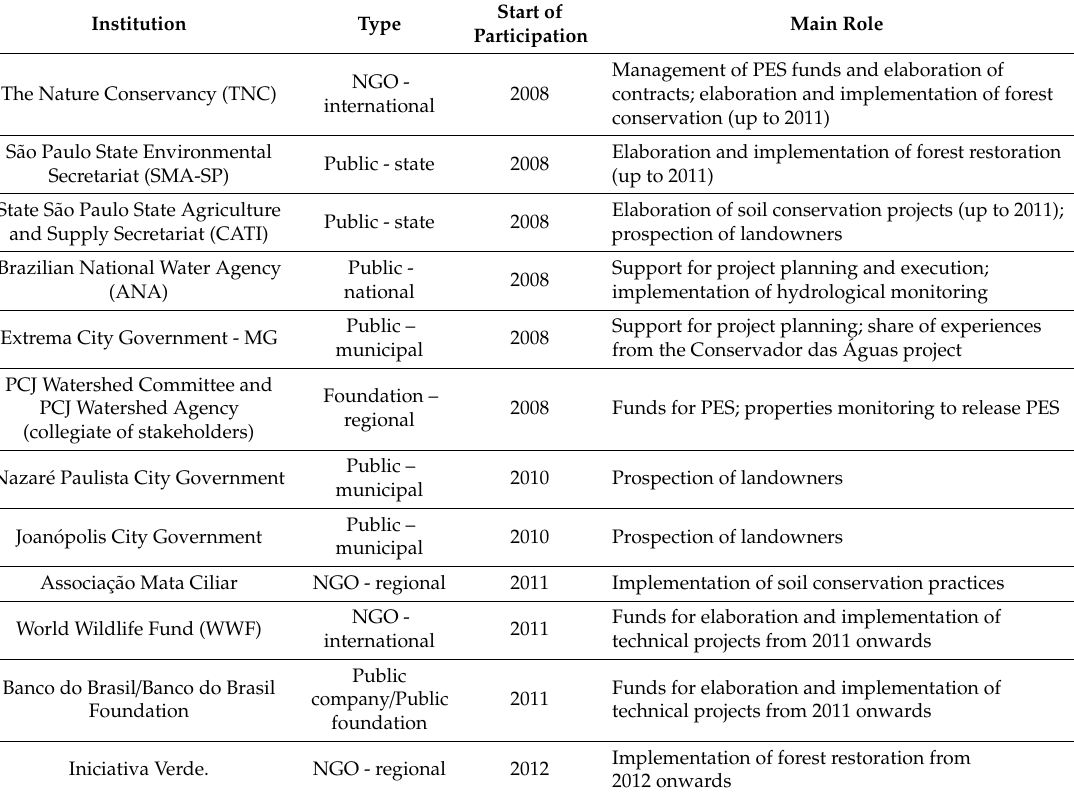
Table A1. Institutions participating in the Water Producer Project at the Piracicaba, Capivari, and Jundiai Watershed, Atlantic Forest, Brazil.